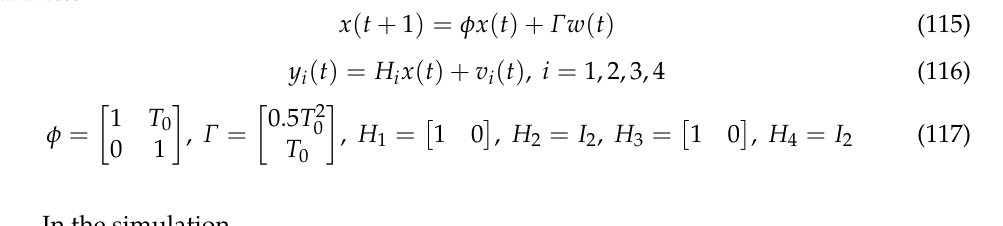
In the simulation, T 0 = 0.25, Q = 1, R 1 = 0.8, R 2 = diag ( 8, 0.36 ) , R 3 = 0.5, R 4 = diag ( 0.25, 10 ) , Q = 0.8, R 1 = 0.65, R 2 = diag ( 6, 0.25 ) , R 3 = 0.45, R 4 = diag ( 0.2, 9 )